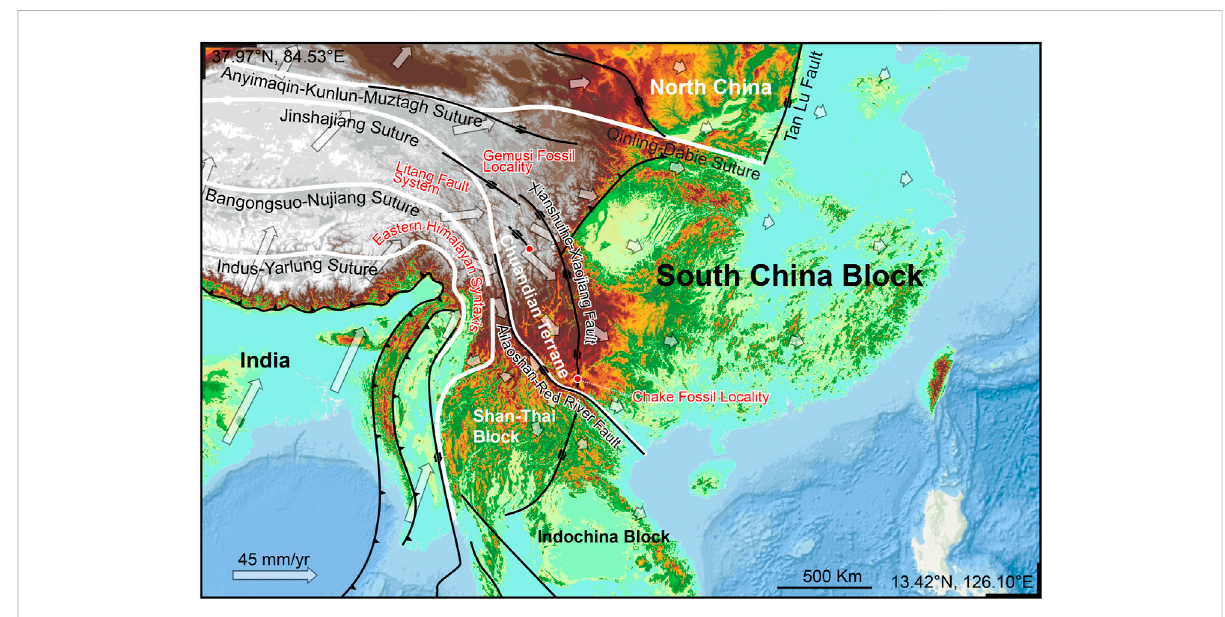
FIGURE 5 Chuandian Terrane and the major faults in the accommodation zone in the southeastern margin of Qinghai-Tibet Plateau. Hollow arrows indicating modern GPS velocity fi eld (based on Wang and Shen